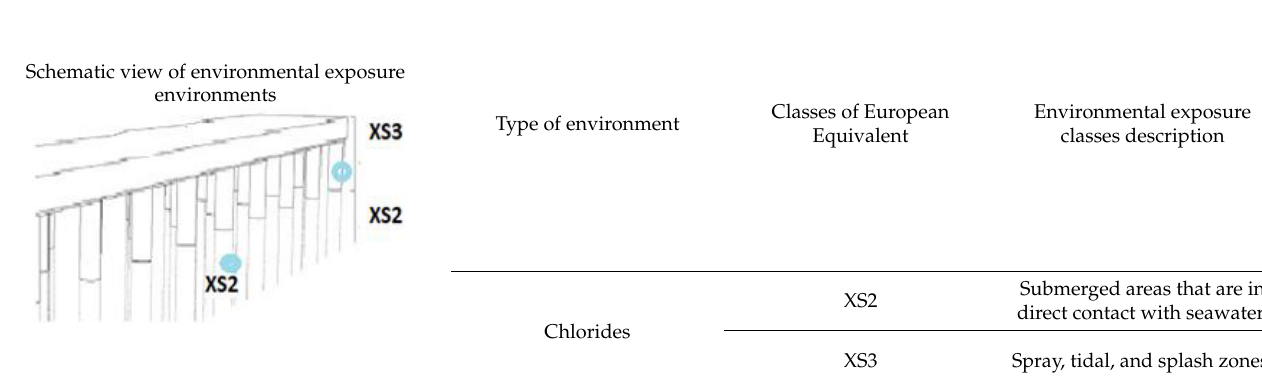
Table 2. Environmental exposure classes of corrosion: EN 1992-1-1 (2004) [46] and EN 206-1 (2005) [43]. Schematic view of environmental exposure Schematic view of environmental exposure environments